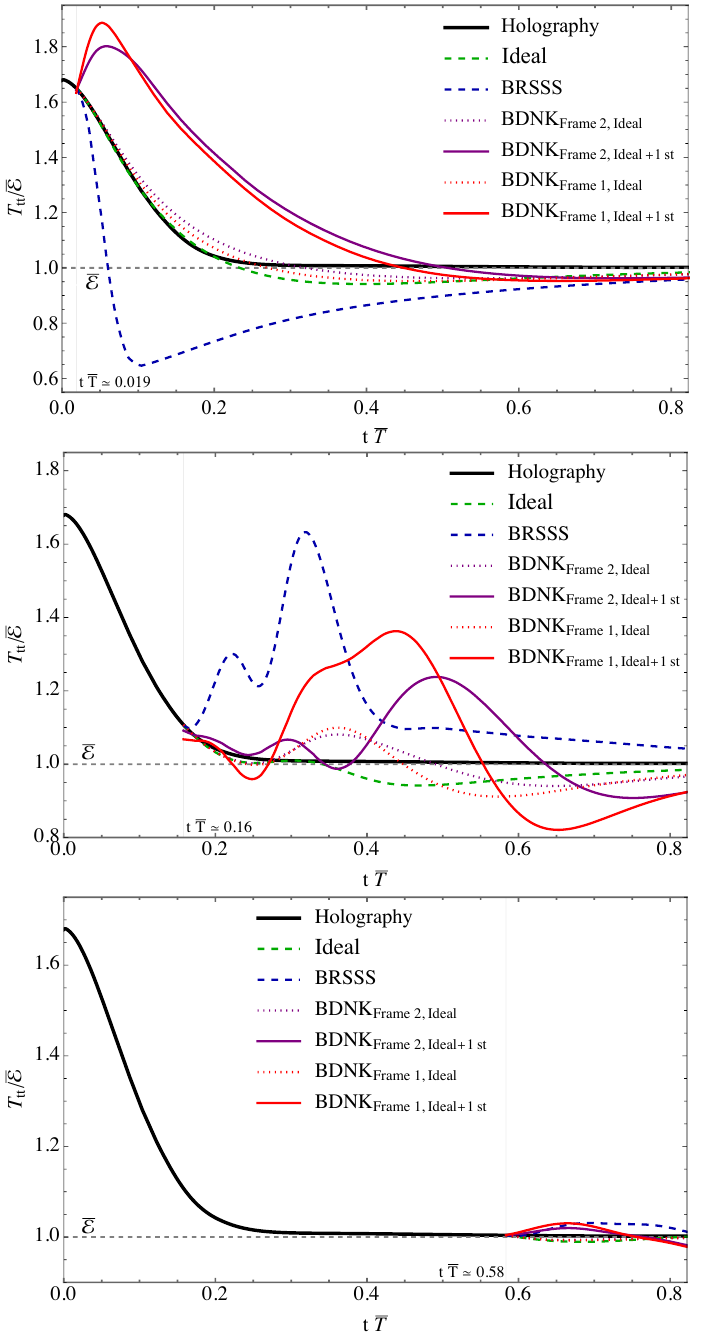
Figure 8 . Energy density in the lab frame, T tt , at the center of the domain { x, y } T = { 0 , 0 } as a function of time. Black continuous line corresponds to the microscopic holographic solution. We include the results of the hydrodynamic evolutions initialised with holographic data at tT ’ 0 . 019 , 0 . 16 , 0 . 58 , from top to bottom. For the BDNK evolutions, we include the result of using only the 0th order terms (the ideal part) in (2.10), in dotted lines. We also include the evolutions of BDNK in the frame